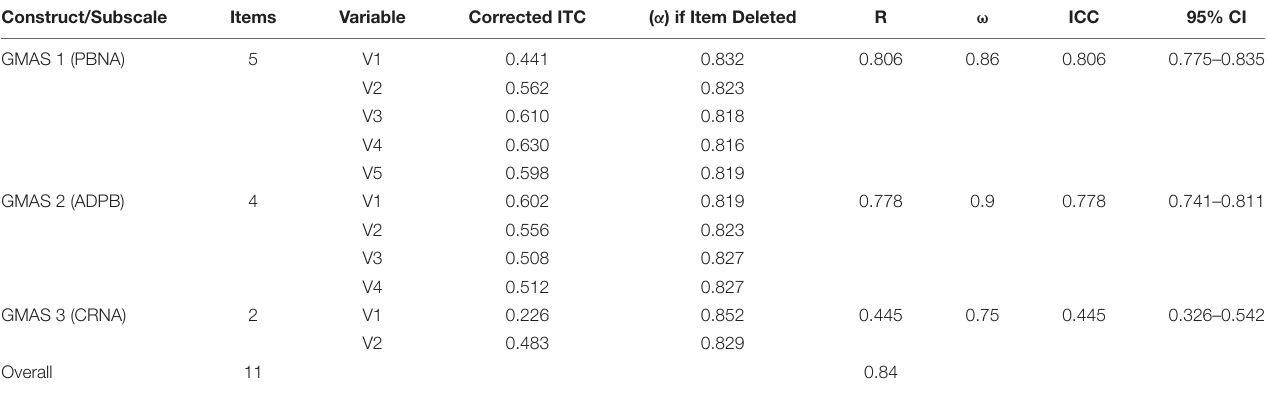
TABLE 3 | Internal consistency results of